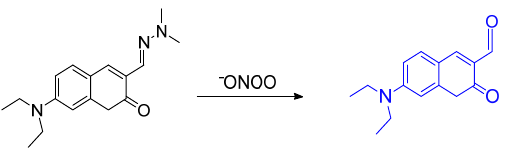
Figure 75. Hydrazone cleavage upon peroxynitrite addition.